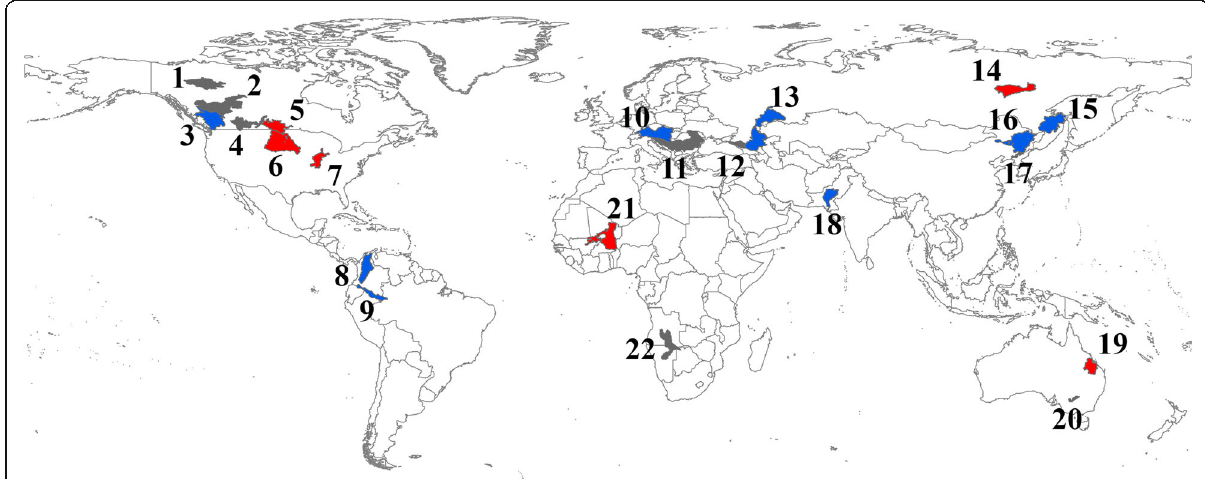
Fig. 1 Effects of anthropogenic radiative forcing on selected historical floods between 2010 and 2013. The locations of enhanced (blue) and suppressed (red) flooding due to anthropogenic radiative forcing, and locations (gray) with non-significant changes. Changes were considered non-significant when the FAR 50 between ALL and the two natural forcing experiments (NAT-cmip5 and NAT-dtr) showed different directions of change. Numbers on the map correspond to the flood events listed in Table